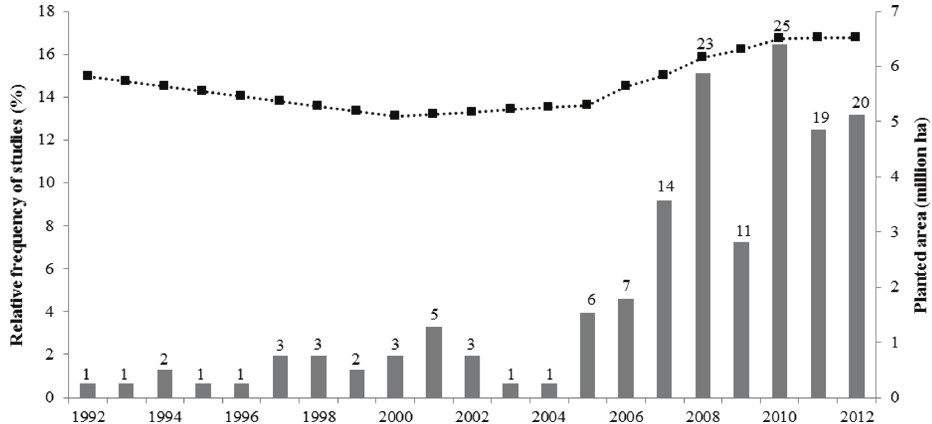
figure 2 - Relative frequency of studies published and area planted with non-native tree species per year between 1992 and 2012. The grey bars represent the number of studies and the black squares represent the area planted with non-native tree species (million hectares) (ABRAF 2012). The numbers on the bars represent the number of studies in each